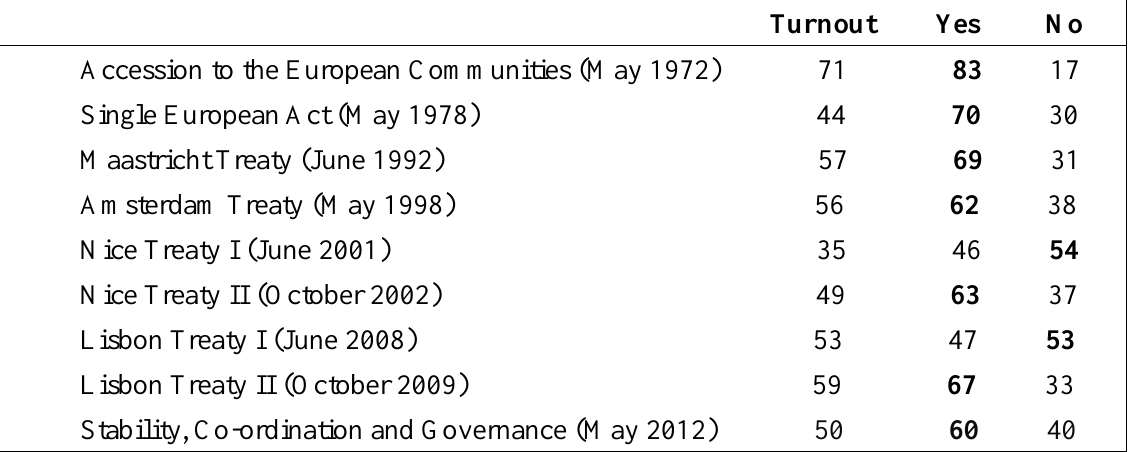
Table 1. European Treaty Referendum Results: 1972-2012